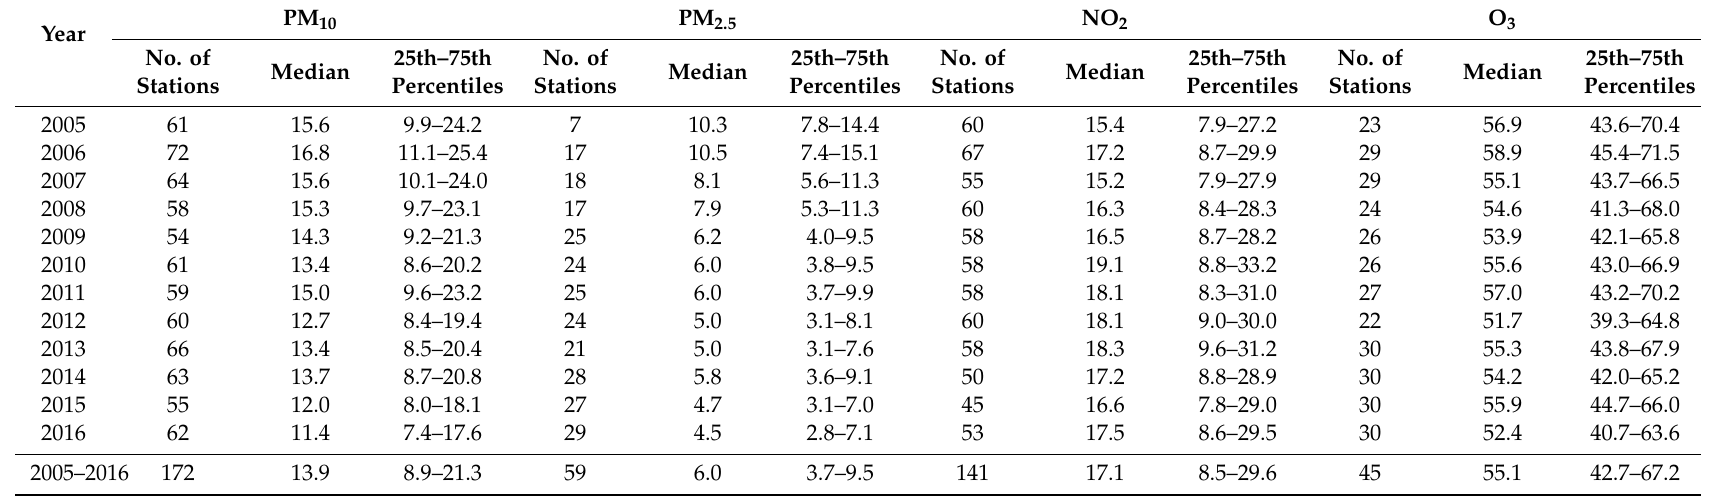
Table 1. Number of monitors per year and pollutant, and descriptive